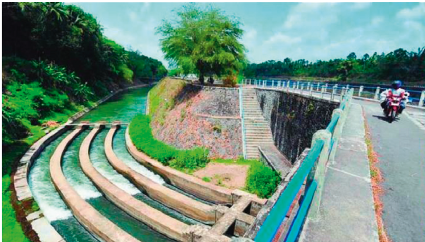
Figure 8: Another side view of irrigation canal in Bligo village, Ngluwar district, Magelang regency, Central Java province,